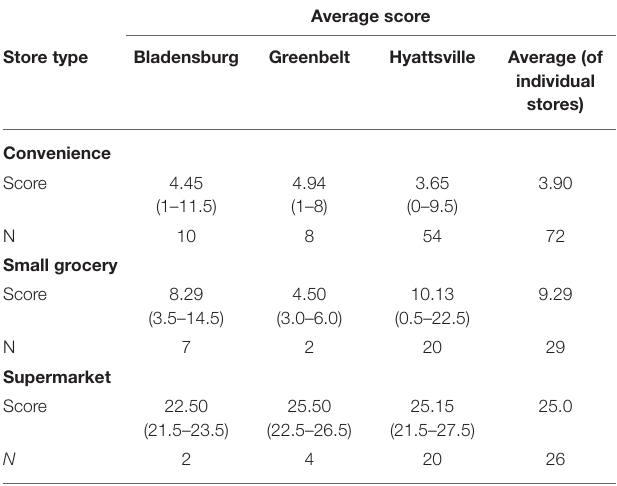
TABLE 3 | Mean HFAI score for each store type in and across study